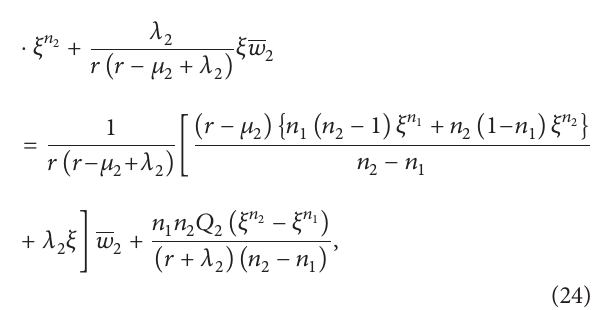
Figure 1: Numerical